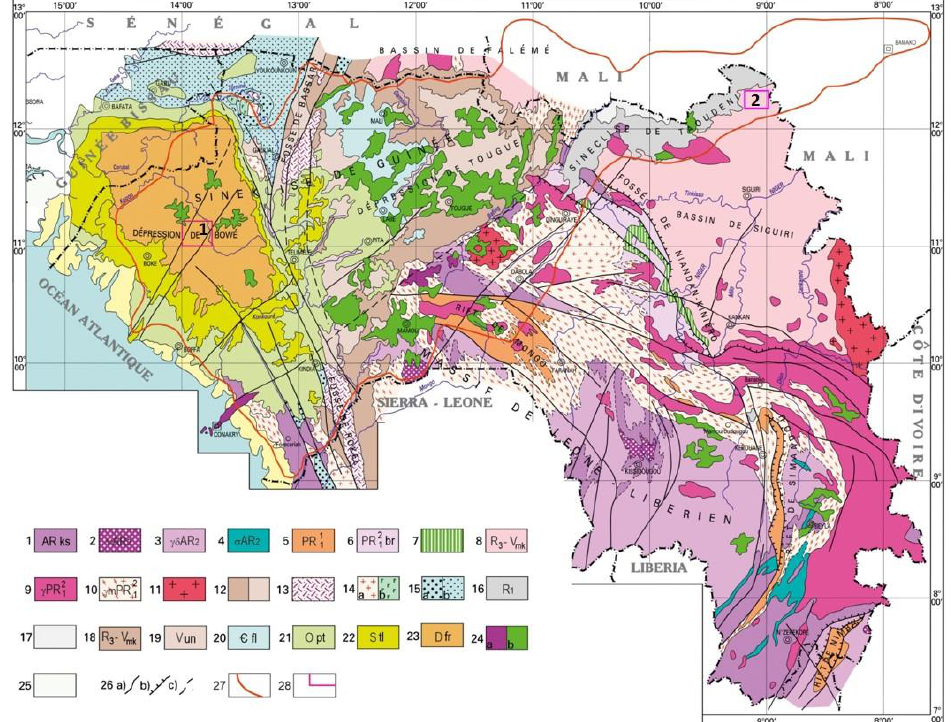
Figure 2. Tectonic framework of Guinea-Bissau and the western part of the Republic of Guinea with the province of Fouta Djallon-Mandingo outlined in red. The crystalline basement of the African platform. Crystalline foundation base. 1—gneisses and schists with quartzites and orthoamphiboltes (Kasila, Dabola, Cambui, and Mani groups); 2—charnockites, enderbites, and anorthosites; 3—granitoids; 4—metanorites, amphibolites, metapyroxenites, and metahyperba- sites; 5—the folded cover of the crystalline basement; sedimentary structures of the Early Protero- zoic orogeny—metamorphosed terrigenous sediments with bodies of metagabbroids, metapyroxen- ites, and amphibolites (Tinikan Group, Mongo, and Timbo formations); 6—sedimentary structures of the late stage of the Early Proterozoic orogeny-terrigenous-volcanogenic formations (Birimian Group); 7—metasandstones, quartz-mica schists, and amphibolized mafic rocks; 8—sheared sand- stones, phyllite-like shales, and phyllites (Birimian Group); 9—granitoids; 10—granite-gneisses and migmatites; 11—granites and aplites; 12—sandstones, siltstones, sericite-chlorite shales, and quartzites (Madina–Kouta and Oundou groups); 13—volcanic-sedimentary deposits (Pananpou, Koubia, and Bania formations); 14—intrusions of (a) acidic and (b) basic composition; 15—continental terrigenous deposits: (a) gravelstones and conglomerates with interlayers of siltstones and (b) ar- coses (Youkounkoun and Taban groups); 16—sediments (Segou Group and Dabatou Formation); 17—argillaceous-carbonate deposits (Bale Formation); 18—sandstones, siltstones, sericite-chlorite shales, and quartzites (Madina–Kouta Group); 19—siltstones and mudstones with interlayers of quartzite sandstones (Oundou Group); 20—marine terrigenous and terrigenous-carbonate